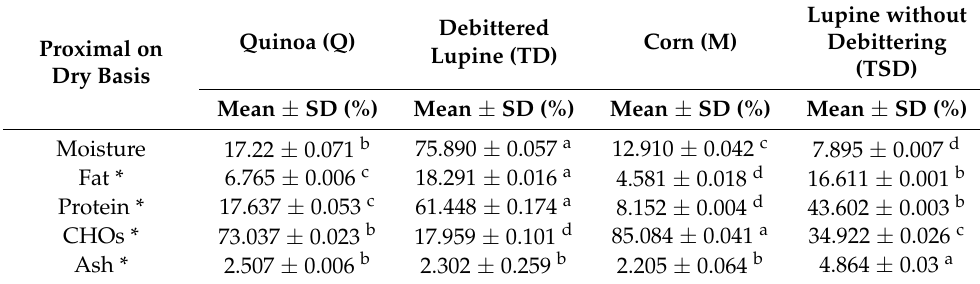
Table 2. Proximal composition of raw